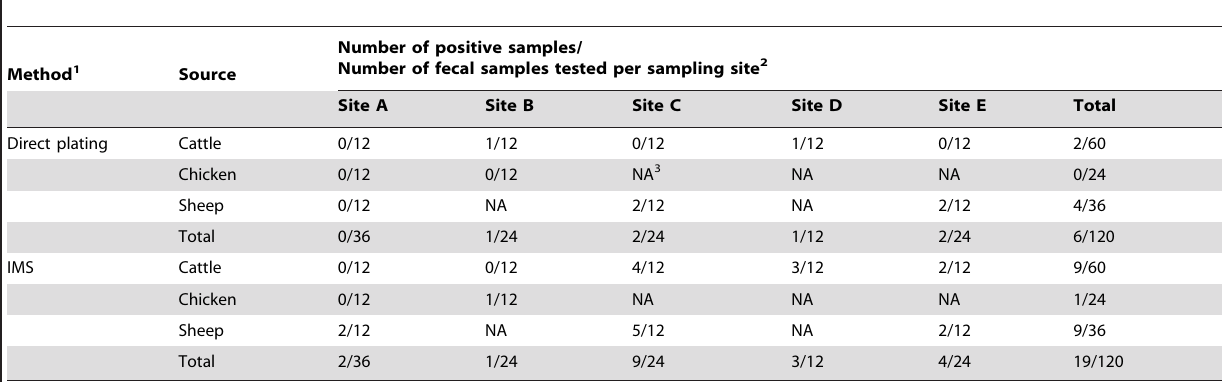
Table 1. Proportion of fecal samples positive for presumptive